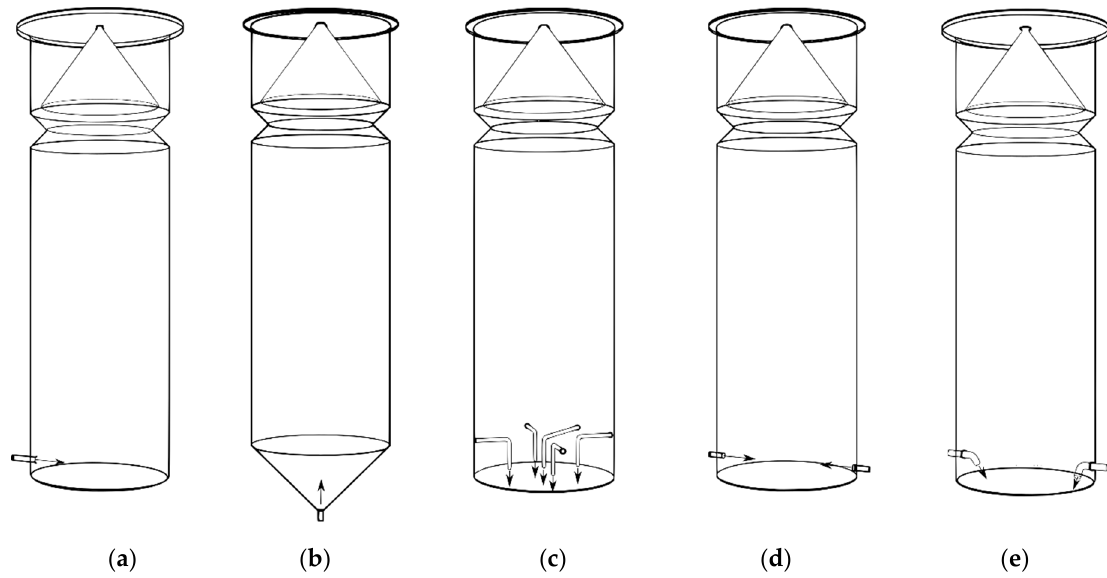
Figure 2. IDS configurations evaluated with CFD. ( a ) Single radial inflow (C1); ( b ) upward axial inflow (C2); ( c ) downward distributed axial inflow (C3). ( d ) Opposite double radial inflow (C4); ( e ) downward tangential inflow (C5).